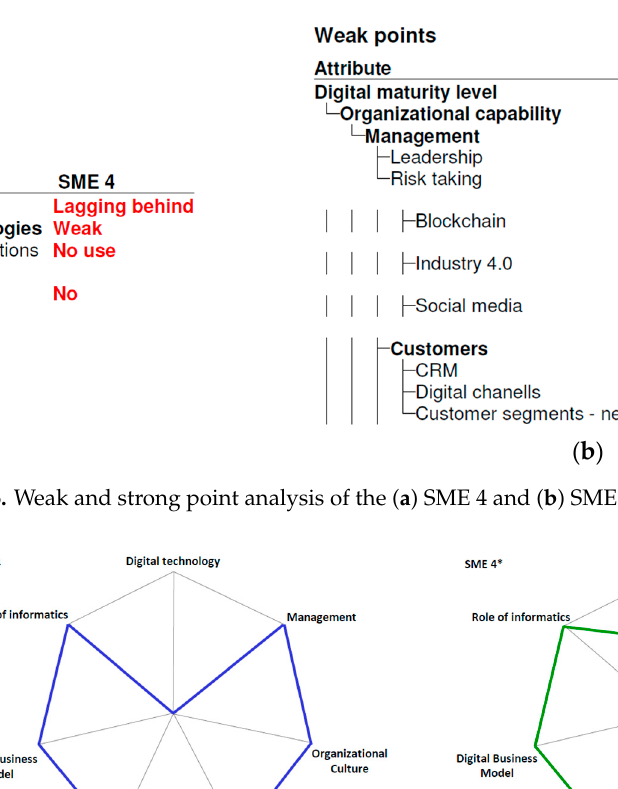
Figure 5. Polar chart for assessment of second-level aggregate attributes for selected SMEs.